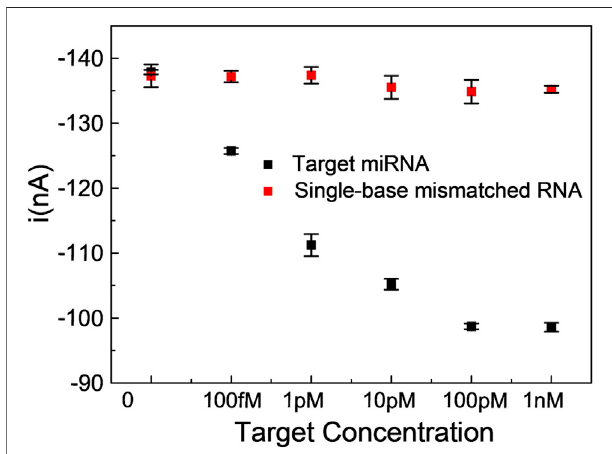
FIGURE 5 | Comparison of SWV peak current values of a single-base mismatched RNA with miRNA141 in the concentration range of 100 fM ∼ measurements.